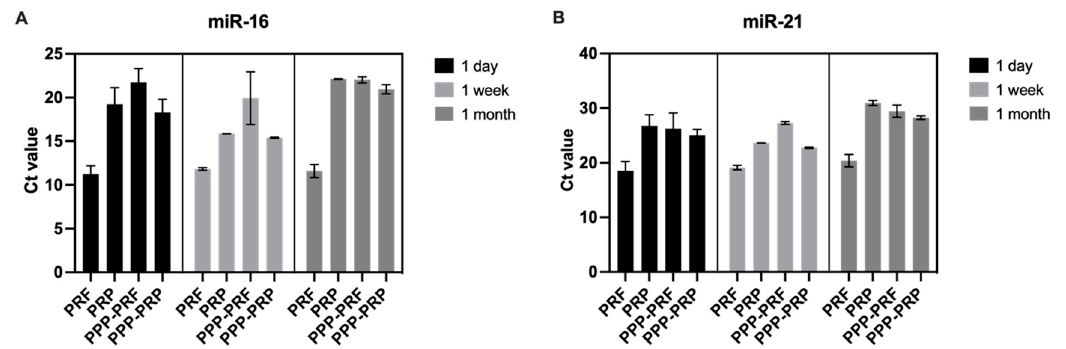
Figure 4. miR-16 ( A ) and miR-21 ( B ) are stable in different autologous blood products of canines. Samples were frozen at − 30 °C for one week and one month before whole RNA collection. The graph represents the Ct value of qPCR analysis results with mean and standard deviation.